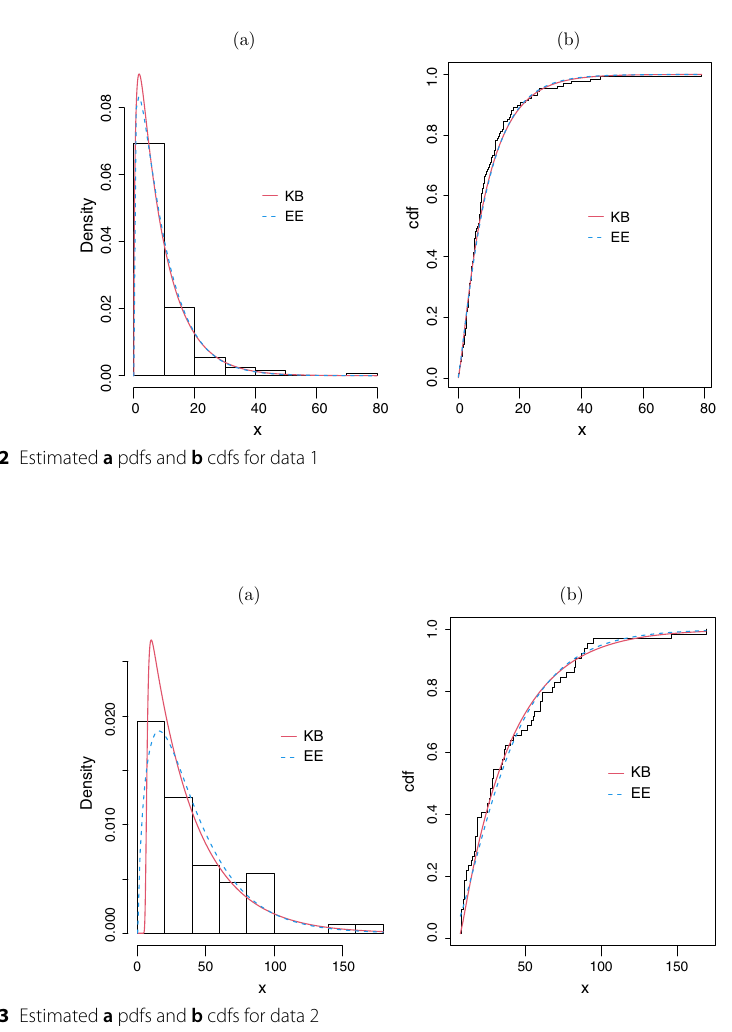
Fig. 3 Estimated a pdfs and b cdfs for data